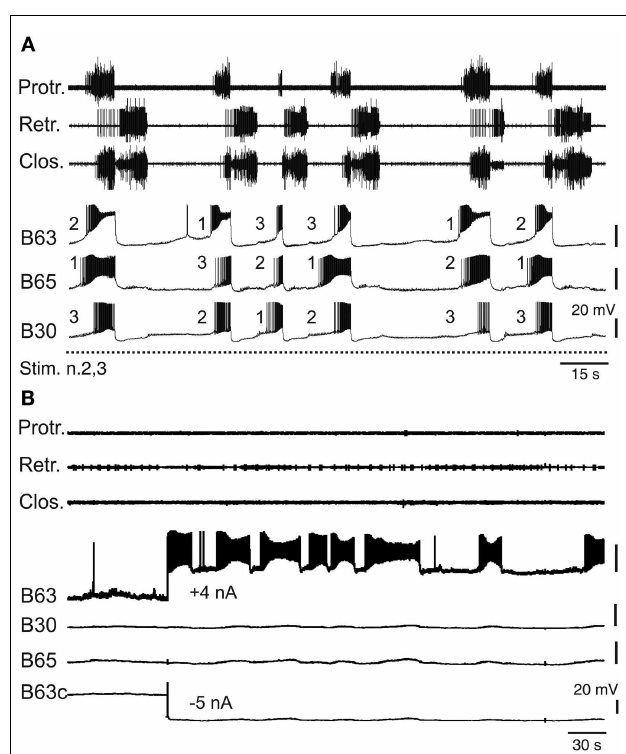
FIGURE 4 |Variability of endogenous anticipatory neuron bursting. (A) Simultaneous extracellular recordings of radula motor patterns (top three traces, same layout as in Figure 2B ) and intracellular recordings of protraction initiating neurons (B63, B65, B30) during tonic (2Hz) stimulation of n.2,3 (Stim. n.2,3).The irregular occurrences of motor patterns were associated with uncoordinated bursting and cycle-to-cycle variability in the order of burst onsets (indicated by numbering) in B63, B65, B30 prior to each motor pattern emission. (B) Endogenous bursting capability of an anticipatory B63 neuron under conditions of functional isolation in situ . In the absence of n.2,3 stimulation and with the contralateral B63 (B63c) held hyperpolarized (by − 5nA current injection) to prevent buccal CPG operation and therefore motor pattern emissions (see top three traces), a tonic depolarization of the other B63 (with + 4nA injected current) elicited repetitive, albeit erratic, bursting in the anticipatory